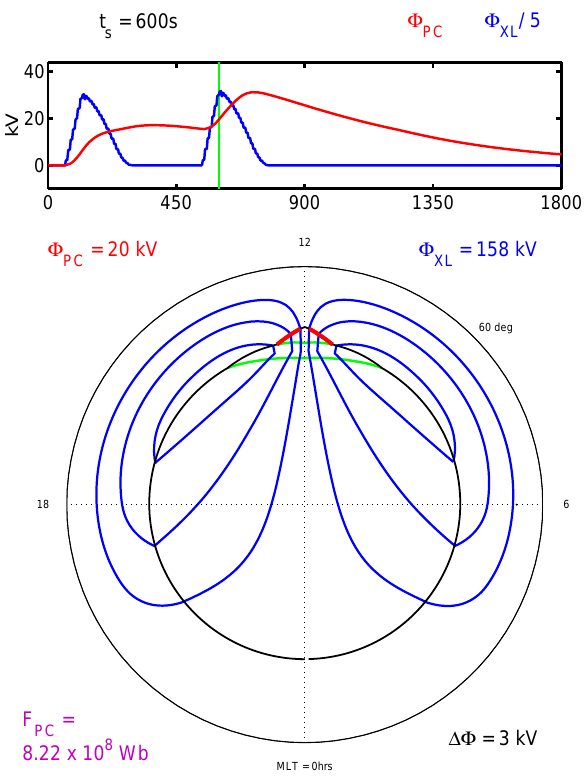
Fig. 3. A model output convection pattern for t s = 600s, 60s after the commencement of the second pulse of reconnection. The format is the same as Fig. 1. Active segments of the OCB, which map to the magnetopause X-line where reconnection is ongoing, are shown in red.